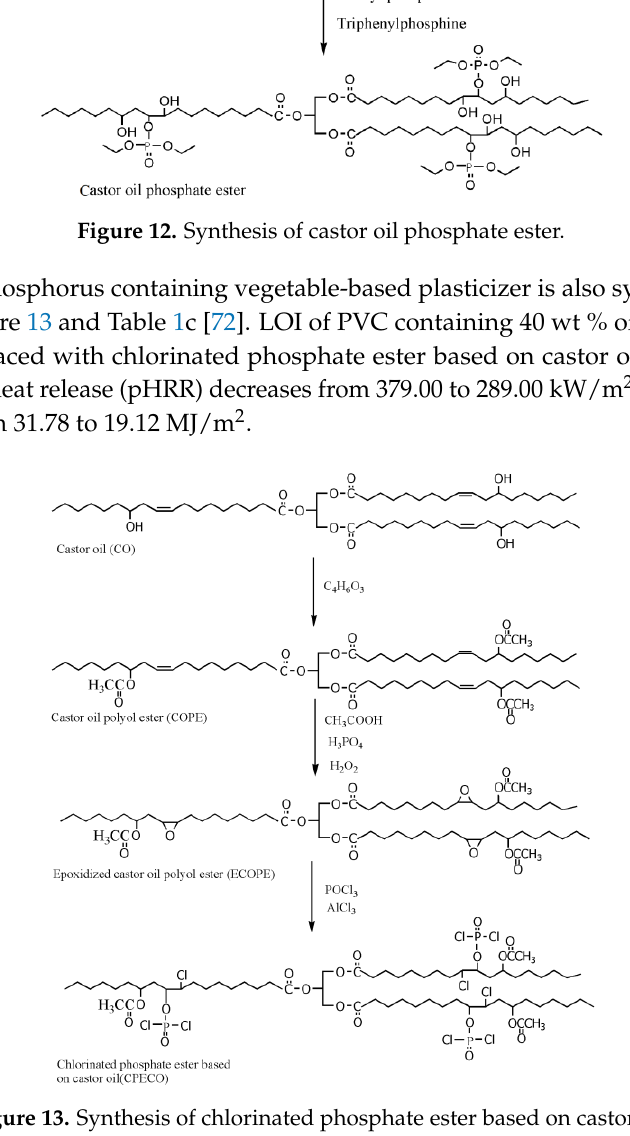
Figure 13. Synthesis of chlorinated phosphate ester based on castor oil.